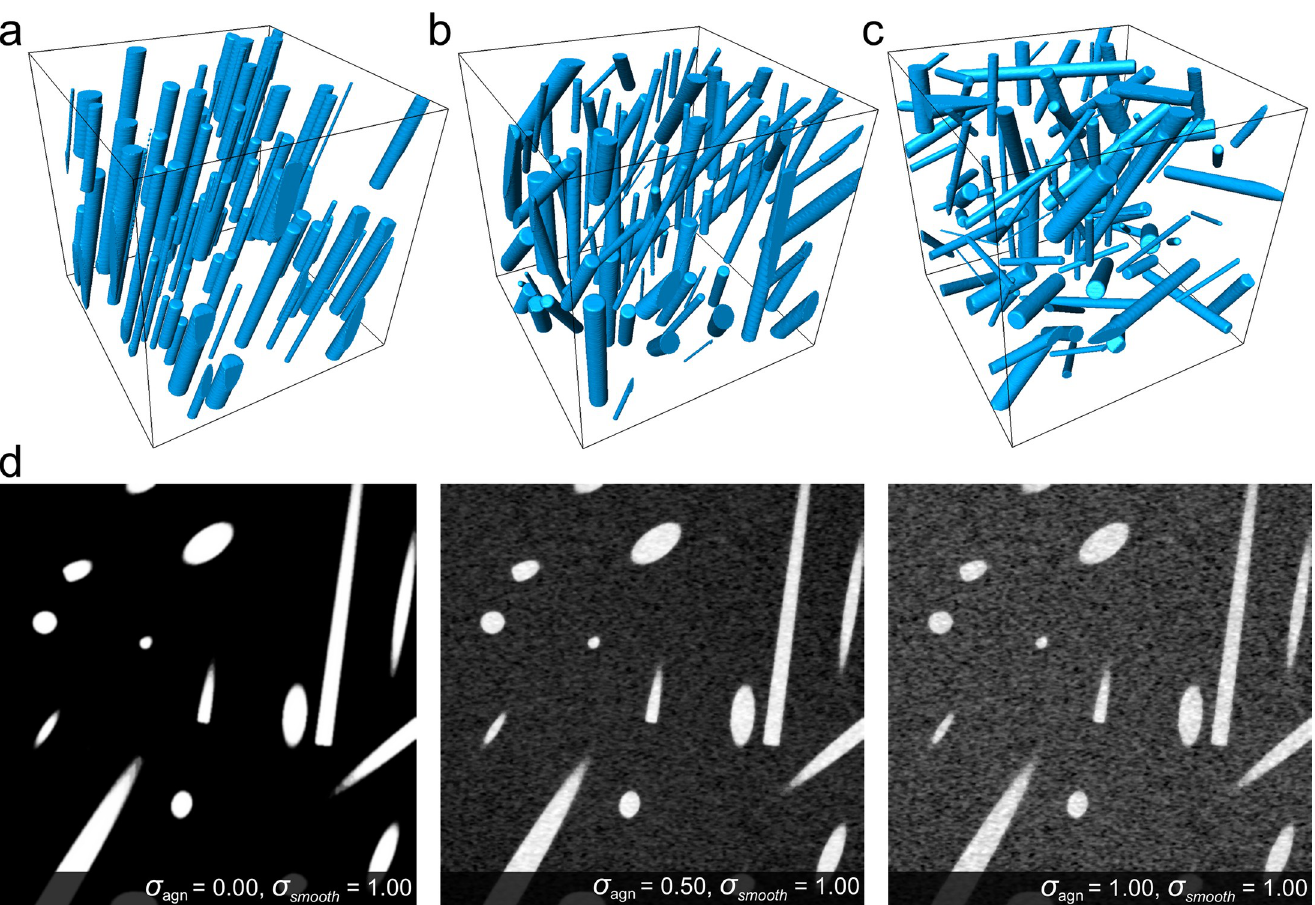
Fig 1. The generated datasets with different fiber configurations: a) aligned (A); b) moderately aligned (M); c) disordered (D); d) the central slice from the YZ-plane of generated disordered dataset contaminated with additive Gaussian noise and smeared with the Gaussian filter.